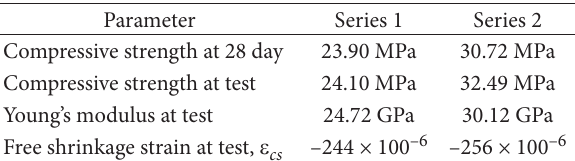
Table 2. Physical and mechanical properties of concrete Parameter Series 1 Series 2 Compressive strength at 28 day